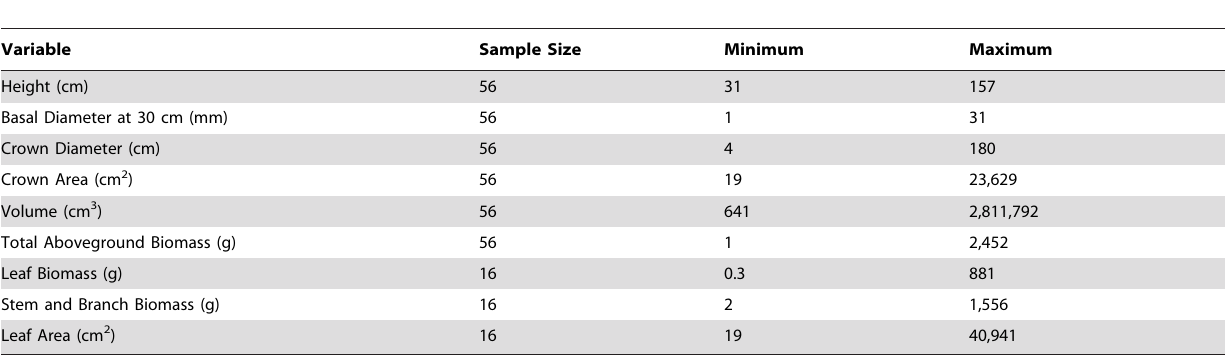
Table 1. Sample size and measurement range of the variables used to develop allometric models for freeze-affected black mangroves ( Avicennia germinans ).